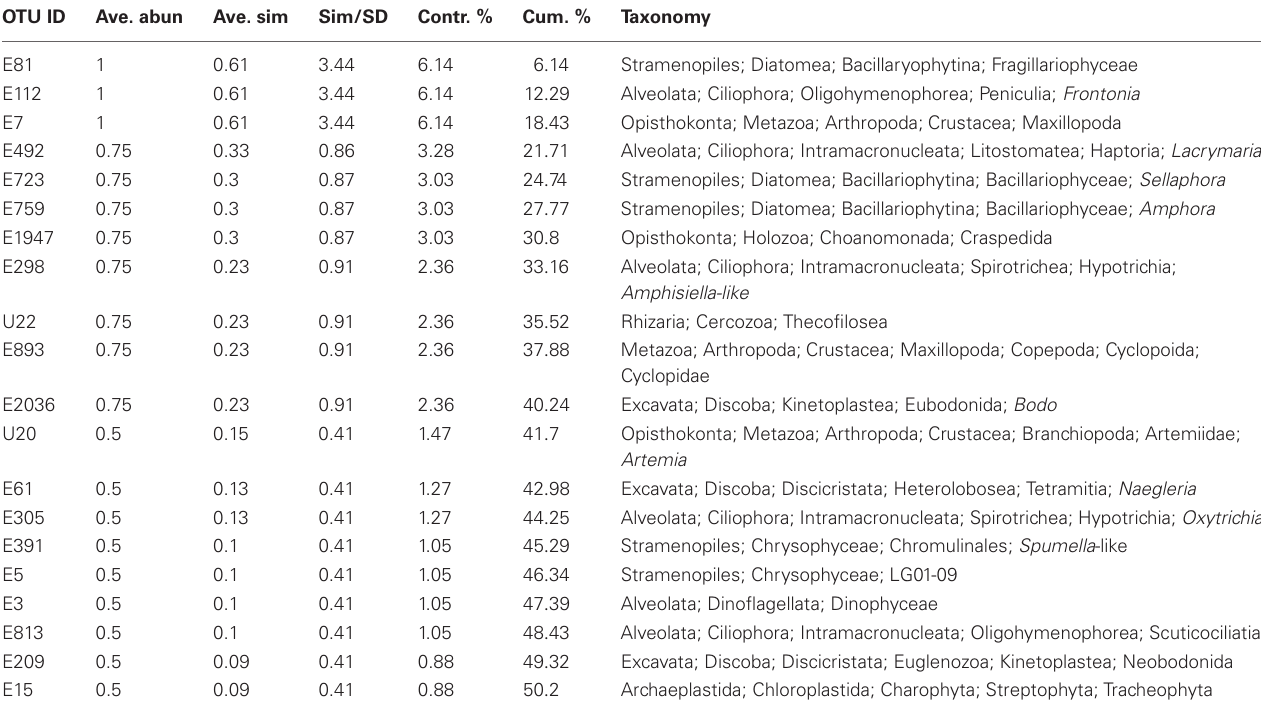
Table A2 | Shared OTUs from alkaline sites determined by SIMPER analysis. OTU ID Ave.